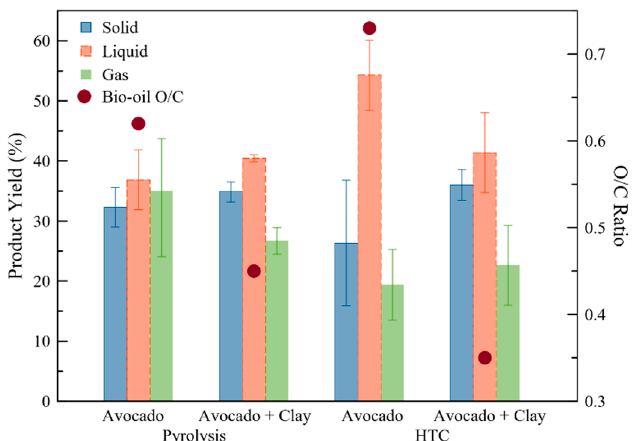
Figure 1. Yield of chars produced from pyrolysis and hydrothermal carbonization (average value is reported with one standard deviation about the mean) . reported with one standard deviation about the